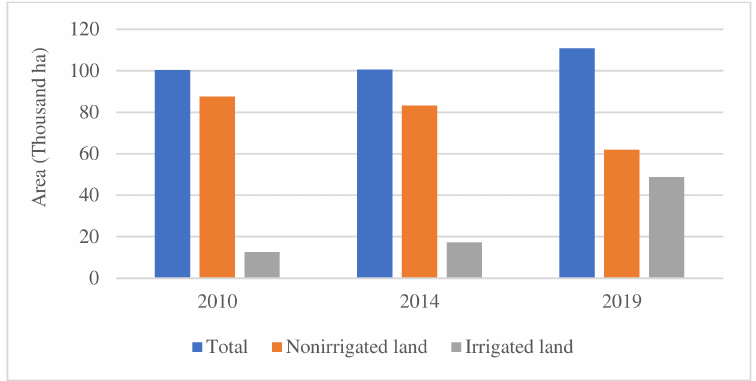
Figure 4. The changes in cultivated land area in Taibus from 2010 to 2019.